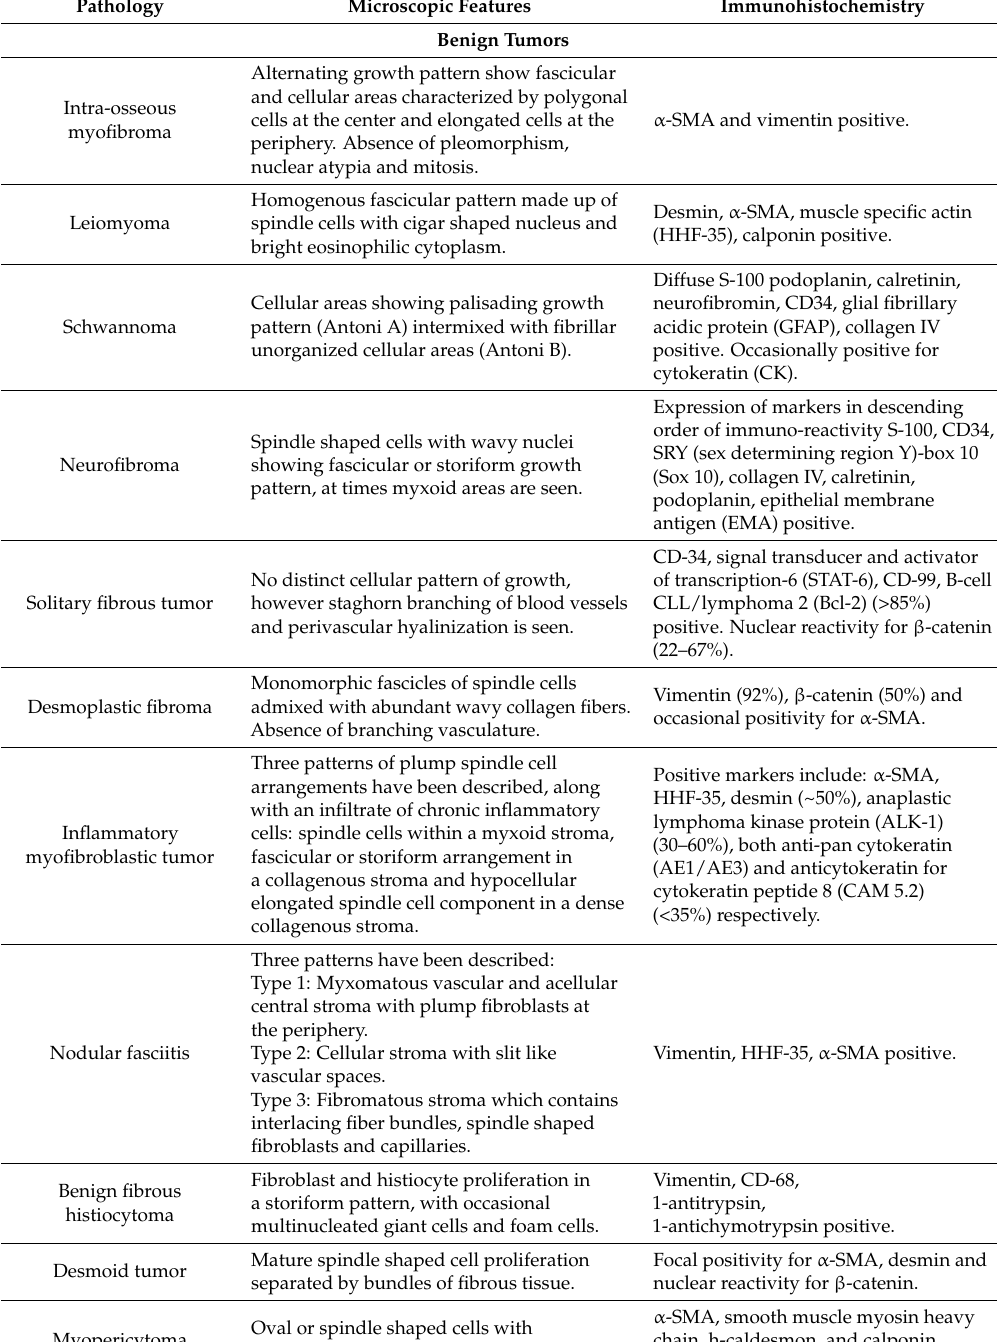
Table 1. Microscopic features and immunohistochemical markers that differentiate intra-osseous myofibroma from other benign and malignant spindle cell tumors that can involve the jaw bone in children